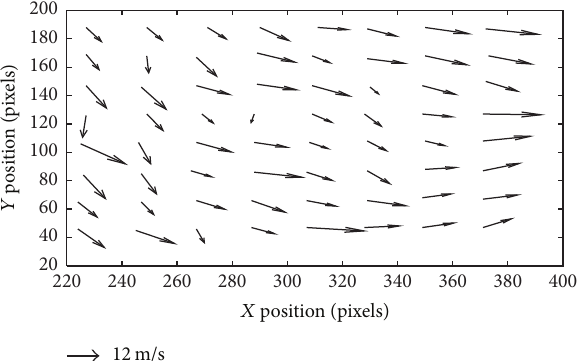
Figure 18: Velocity vector field along an in-cylinder tumble plane at 107 CAD before TDC during compression stroke at 2500 rpm.